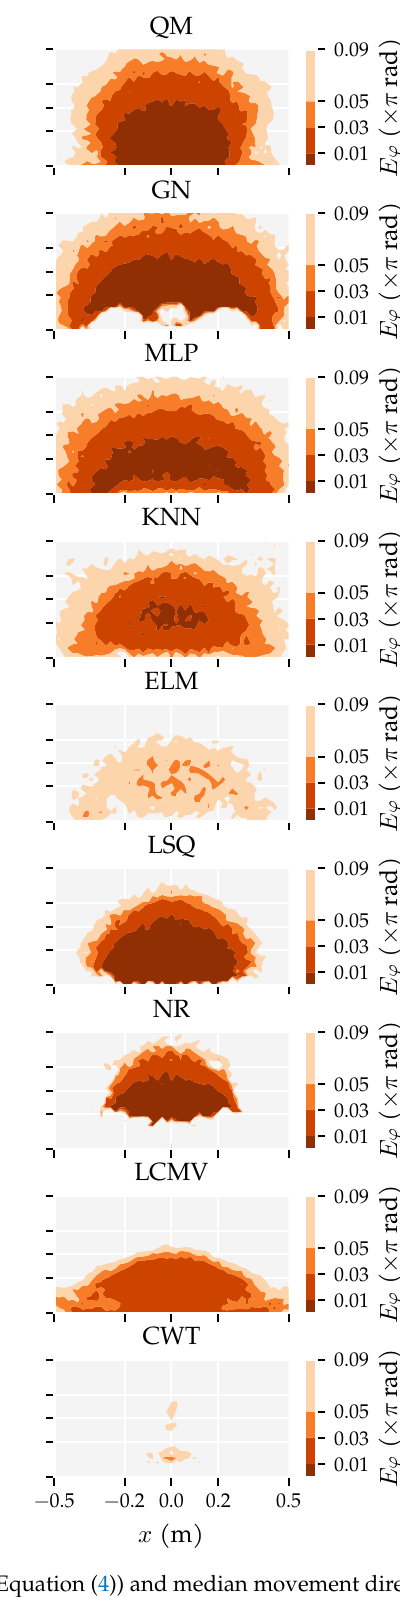
Figure 13. Spatial contours of the median position error E p (blue) (Equation (4)) and median movement direction error E ϕ (orange) (Equation (5)) of the predictors using the largest training and optimisation set ( D s = 0.01) and 2D sensitive sensors (x + y) at the σ = 1.0 × 10 − 5 ms − 1 noise level. The algorithms are ordered with an increasing overall median position error. The median errors were computed in 2 × 2 cm 2